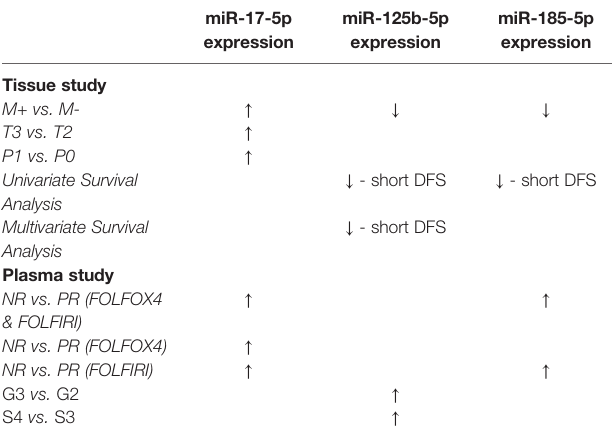
TABLE 6 | Summary of the tissue and plasma